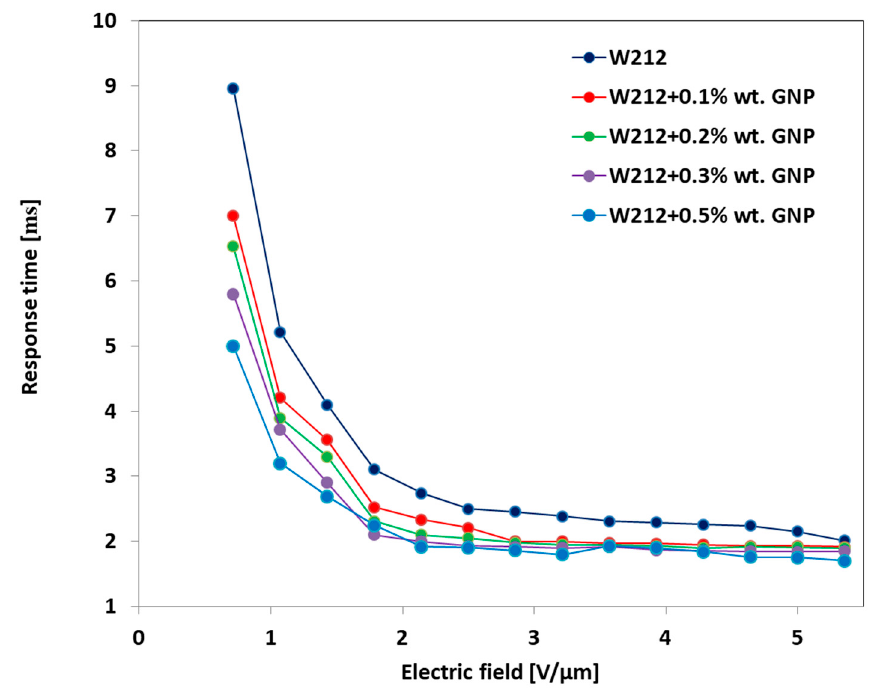
Figure 7. The response times for PLCFs infiltrated with W212 FLC doped with different concentrations of GNPs as a function of applied electric field. Measurements registered at 25 °C.